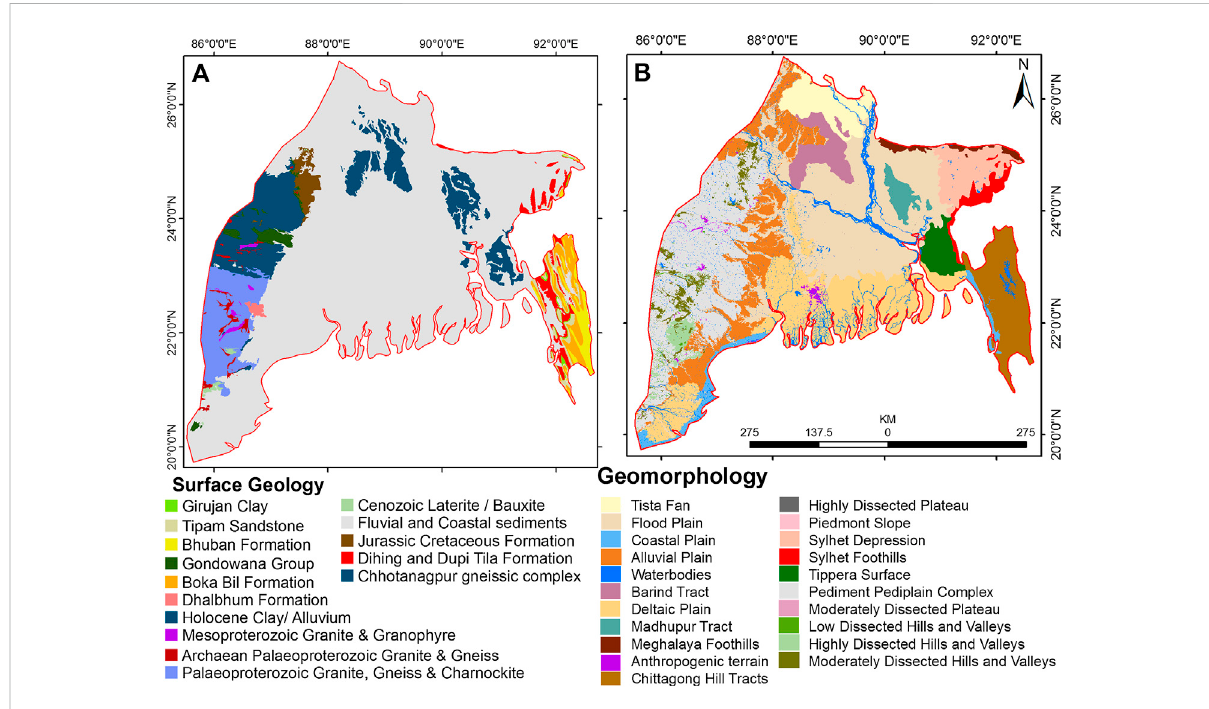
FIGURE 2 (A) Surface geology and (B) geomorphology of Bengal Basin (adopted from USGS and GSB, 2001 and